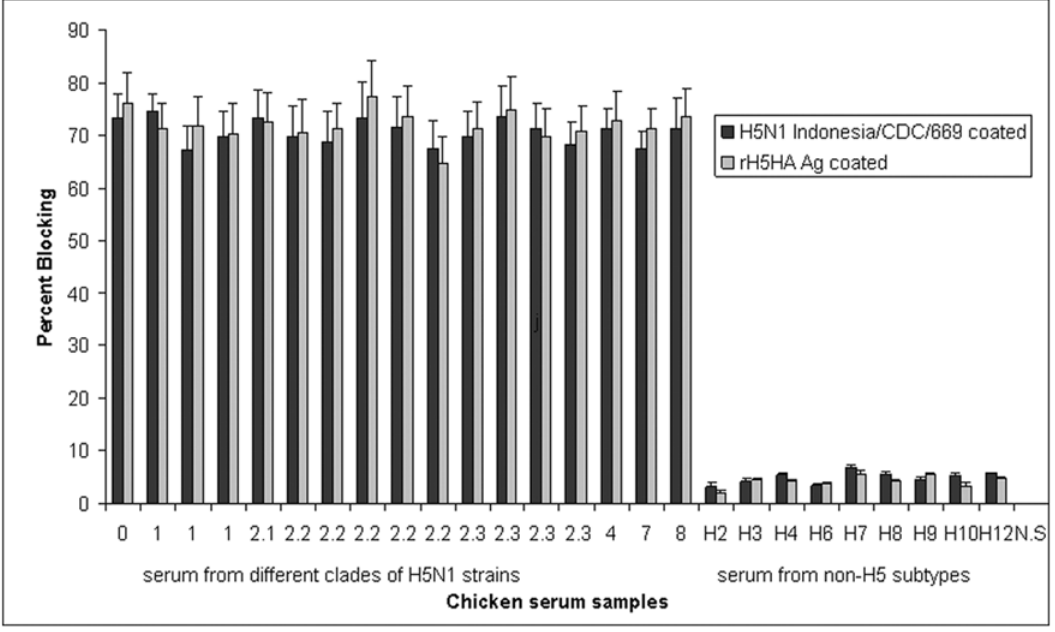
Figure 3. Sensitivity and specificity of the EB-ELISA. Performance of the EB-ELISA with sera from chickens immunized with different clades of H5N1 and other HA subtypes. Chicken sera collected 10 days after second immunization were adjusted to HI titer of 16 and subsequently diluted 5- fold for analysis in EB-ELISA. Antisera to H5N1 clade 0, 1, 2.1, 2.2, 2.3, 4, 7 and 8 and to other subtypes such as H2N9, H3N2, H4N1, H6N8, H7N1, H8N4, H9N2, H10N5 and H12N5 were analysed. Inhibition above the cut-off value of . 30% blocking was considered as positive; i.e. antibodies to H5N1 were present. The results were expressed as the arithmetic mean of percent blocking values (n=5/group, whiskers above bars represent the standard error of the mean). NS: Normal preimmune chicken